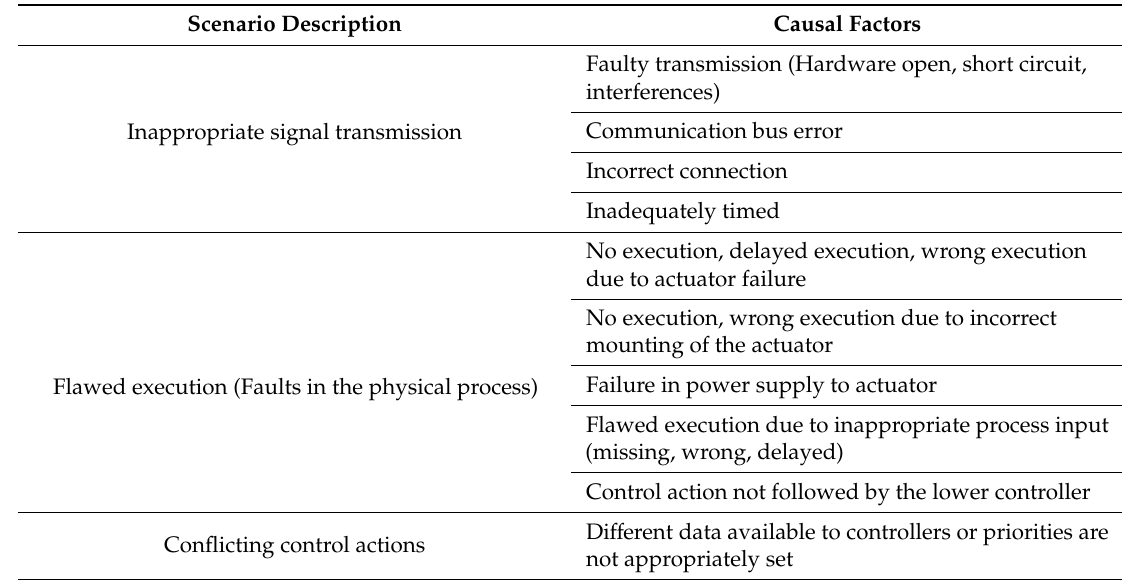
Table A2. Causal factors for followed